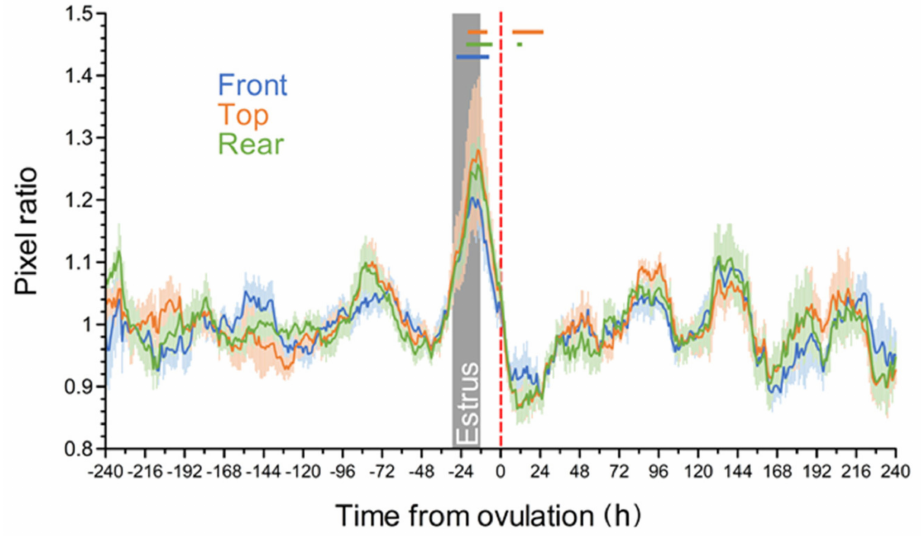
Figure 3. Changes in pixel ratio during a natural estrous cycle in tie-stalled cows. The pixel ratio was calculated as the total value during the last 24 h/total value during the last 24 to 48 h. Blue, orange, and green horizontal bars indicate the time points with significant differences between values at the indicated time point and the corresponding mean values during the reference period ( − 240 h to − 169 h from ovulation) ( p < 0.05, Steel test). The gray vertical bar indicates the mean period of standing estrus (from 29.8 to 12.5 h before ovulation). The data were standardized for ovulation (0 h: red dotted vertical line). Data are expressed as mean ± standard error. Each line includes the data of ten estrous